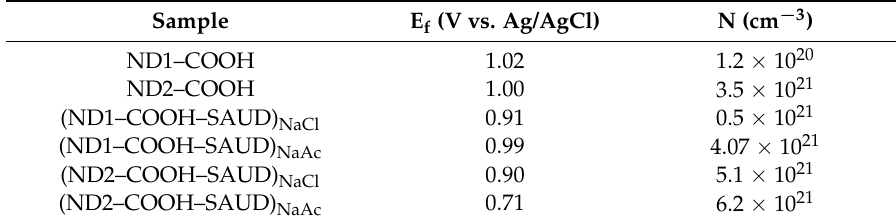
Table 1. The estimated flat band potentials ( E f ) and carrier concentration ( N ) for all the nanodiamond samples in 0.05 M K 2 SO 4